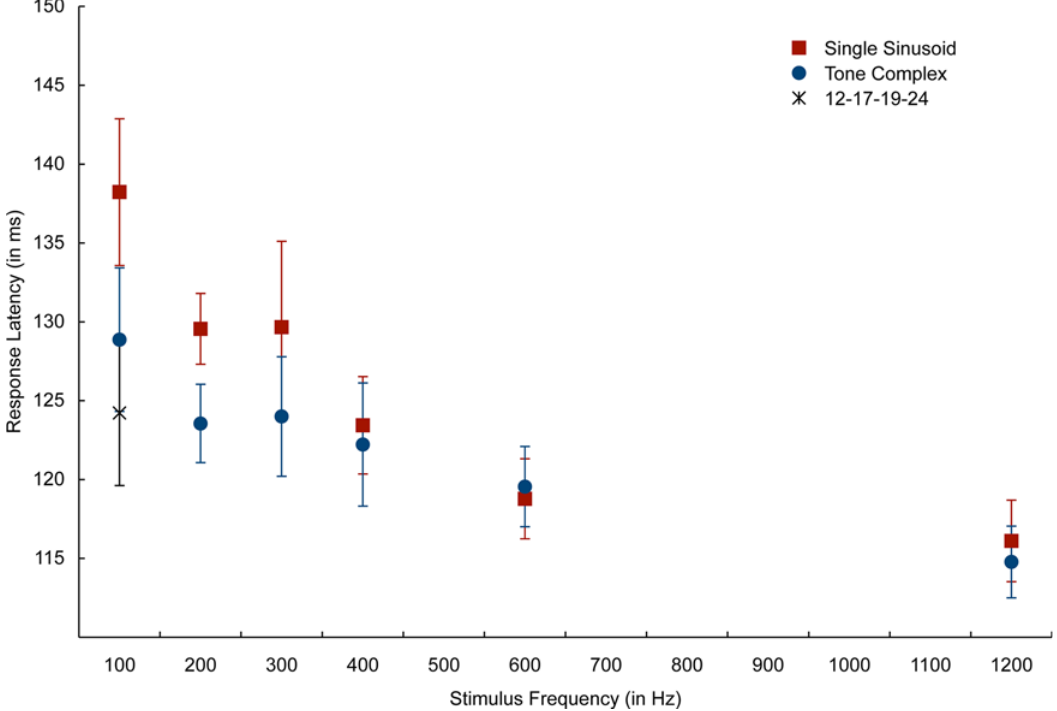
Figure 3. M100 RMS latencies to single sinusoid tones, tone complexes (plotted by their inferred fundamental component), and the 12-17-19-24 kHz tone complex, whose fundamental component is 100 Hz. Error bars refer to 6 1 standard error of the group mean.